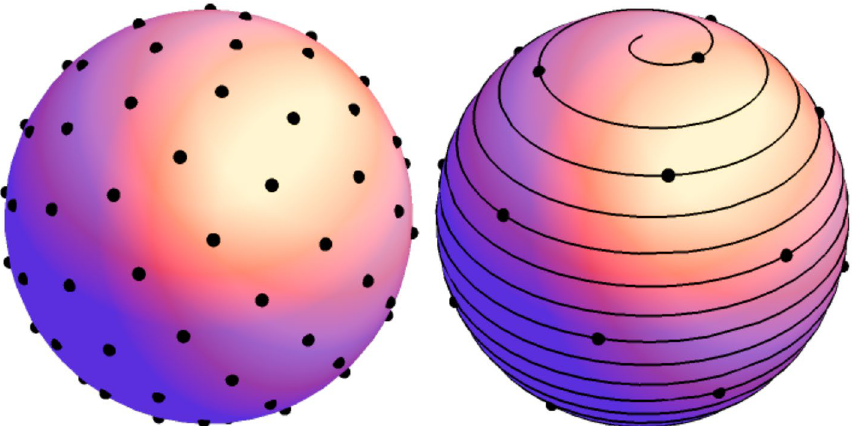
Figure 7. Example of a Fibonacci lattice (left) on the surface of a sphere and one of the Fibonacci spirals that generated it (right). The dots on the spiral are the ones that are included in the lattice on the